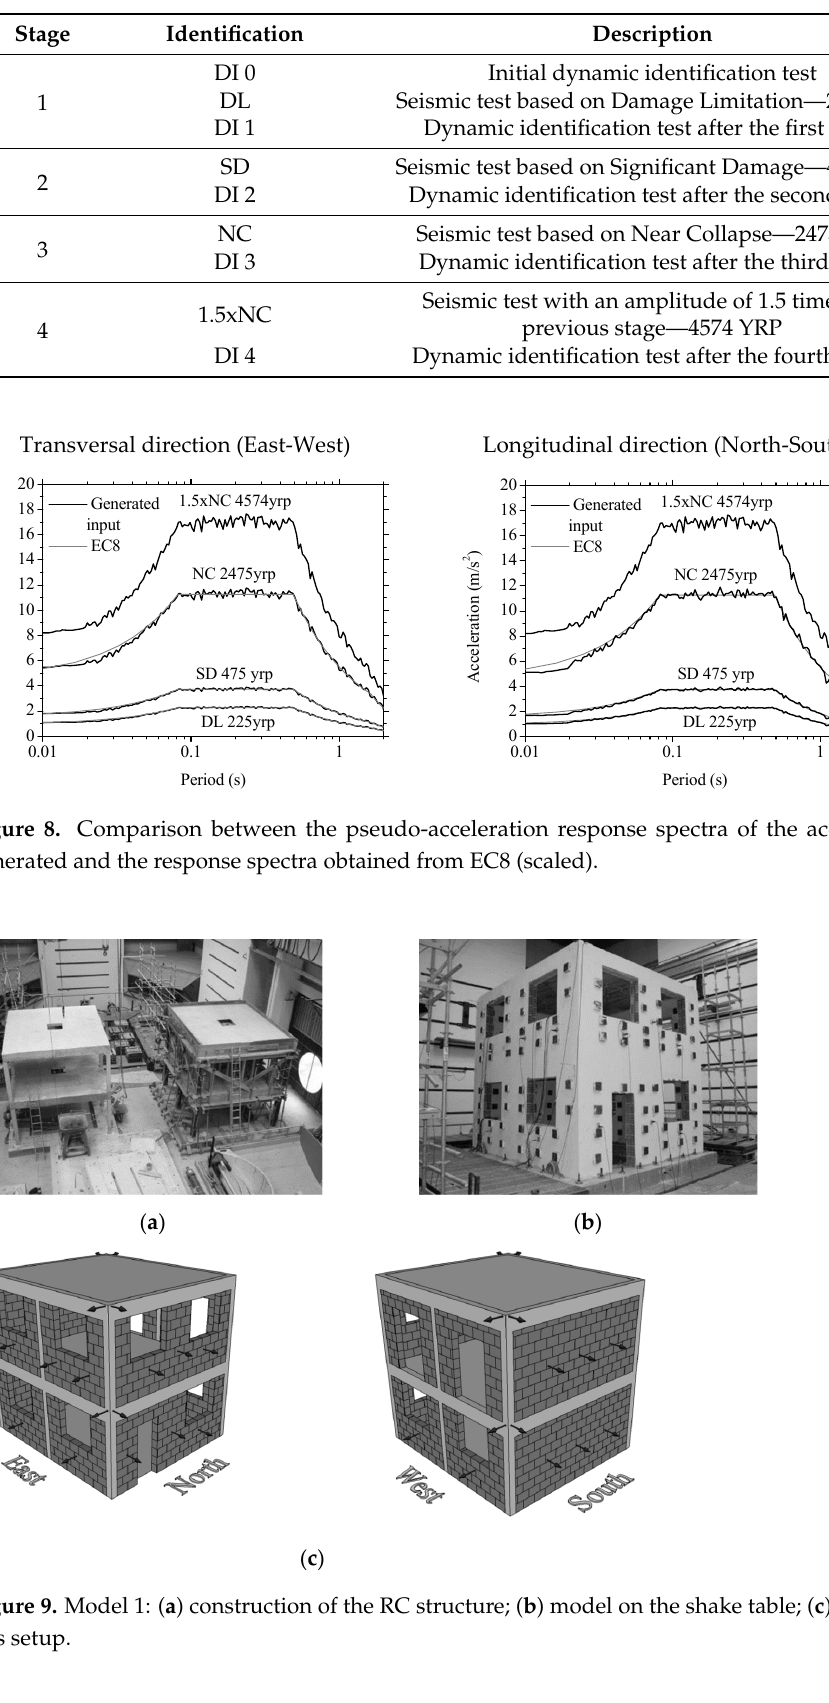
Table 4. Adopted shake table test sequence of inputs.